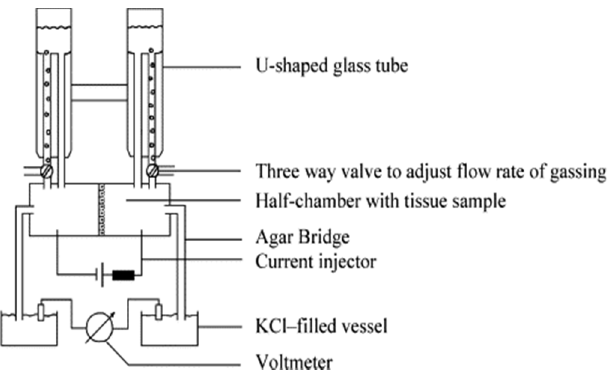
Figure 3. Schematic drawing of a circulating Ussing chamber (taken from [30], license no. 5112401256947).